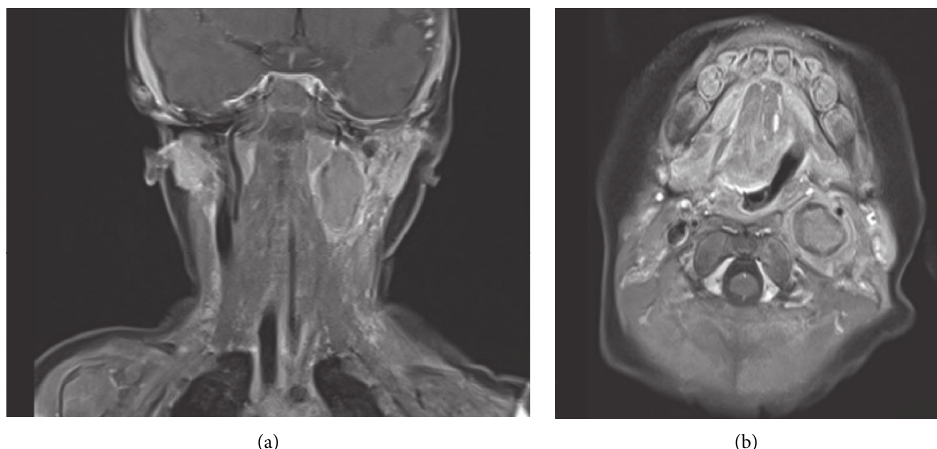
Figure 1: MRI T1-weighted images with fat saturation and contrast, coronal (a) and axial (b) views, depicting a non-enhancing left carotid space tumor. Neuroblastomas typically show variable and heterogeneous enhancement and are of relatively low signal intensity on T1- weighted images and high signal intensity on T2-weighted images